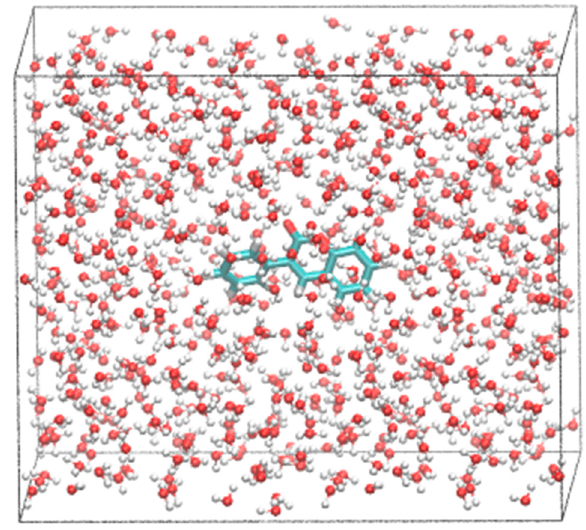
Figure 2. Molecular dynamics (MD) simulation of molecule A inserted in a water box of ~710 water molecules, with periodic boundary conditions.